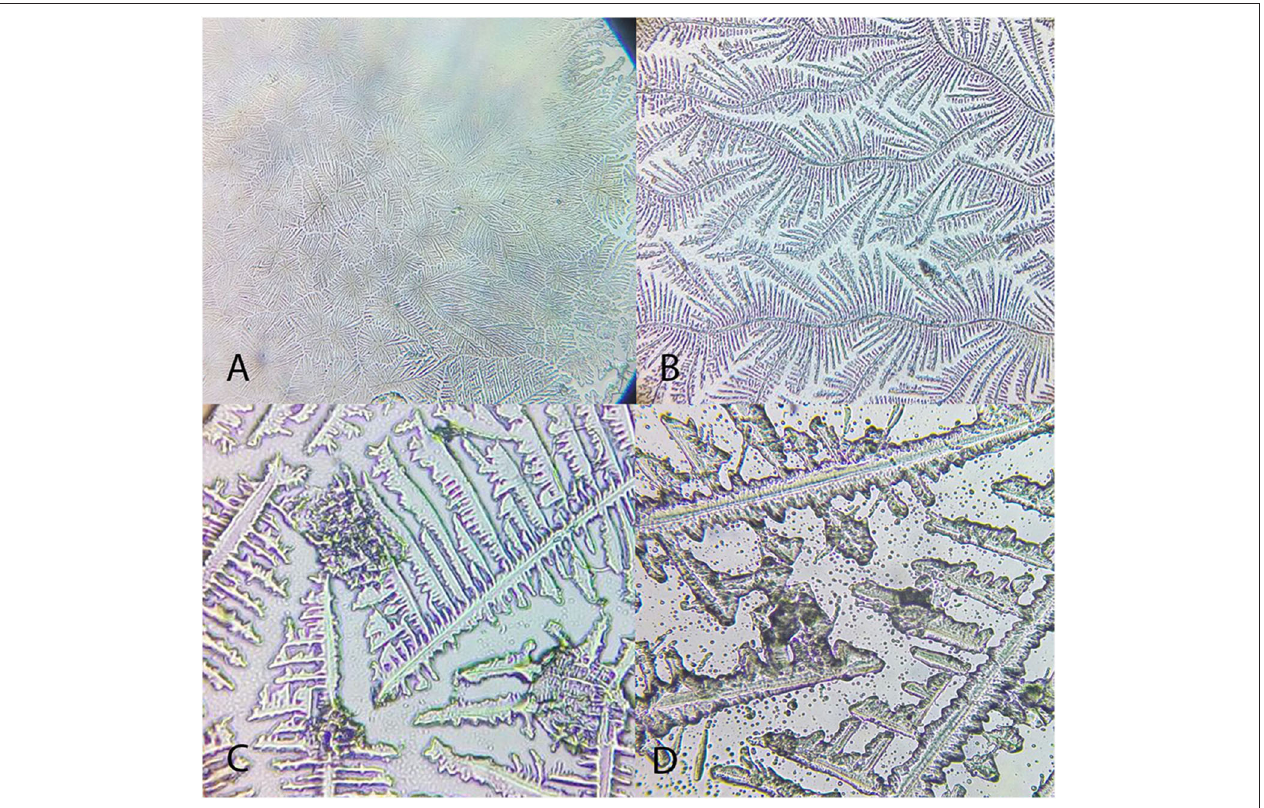
FIGURE 10 | Examples of Caretta caretta tear ferning patterns, according to the Rolando and Masmali grading scales. (A) Type I (Rolando scale), grading 0 (Masmali scale); (B) Type II (Rolando scale), grading 1 (Masmali scale); (C) grading 3 (Masmali scale); (D) Type III (Rolando scale).